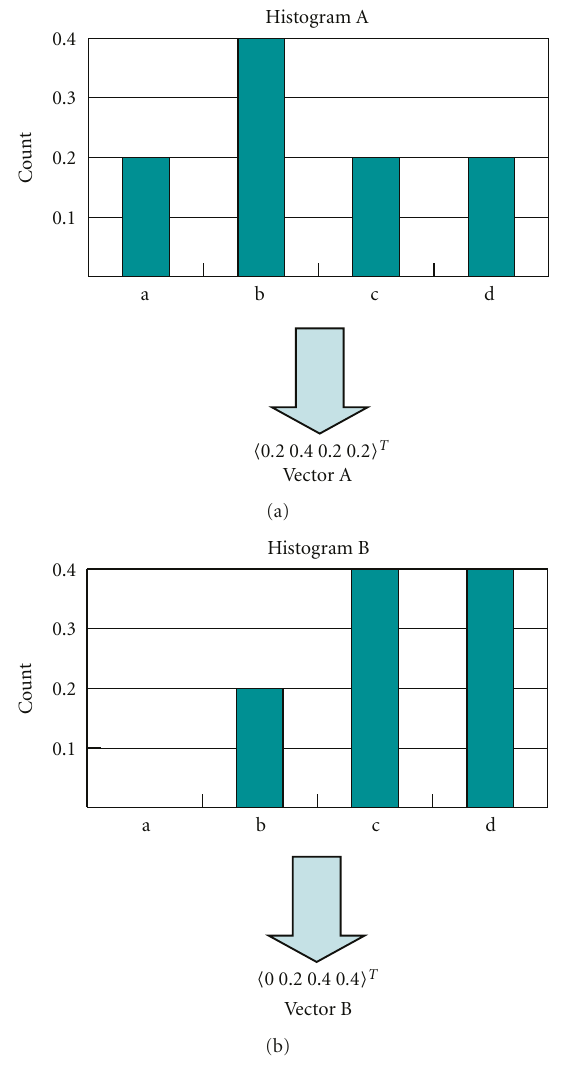
Figure 5: The illustration of representing histograms as vectors.